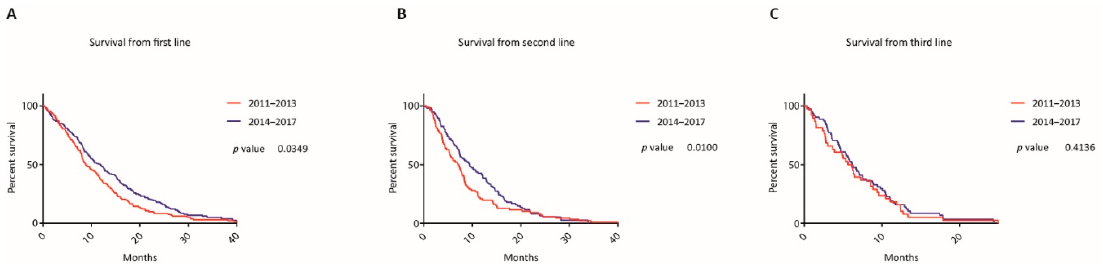
Figure 2. Survival according to treatment lines. Kaplan-Meier curves of patients from initiation of the first ( A ), second ( B ) and third ( C ) line treatment according to the time periods when the first systemic treatment was administered.